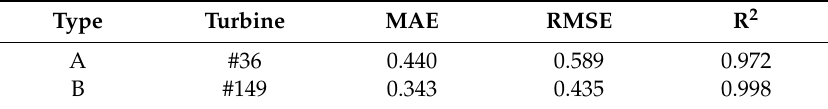
Table 5. Performance of the two normal behavior